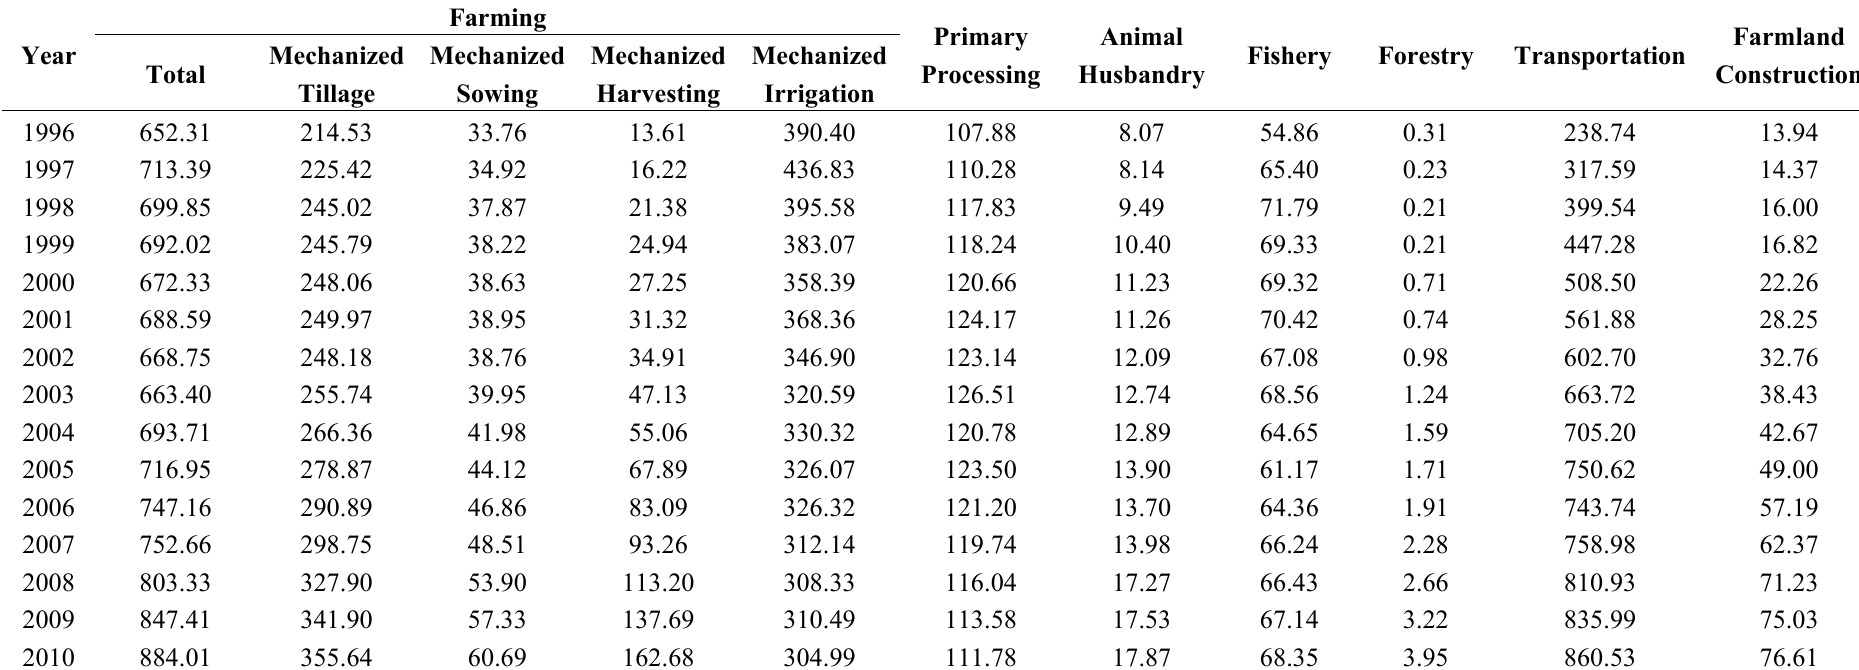
Table 5. Diesel consumption (10 4 ton) in different sectors of agriculture in